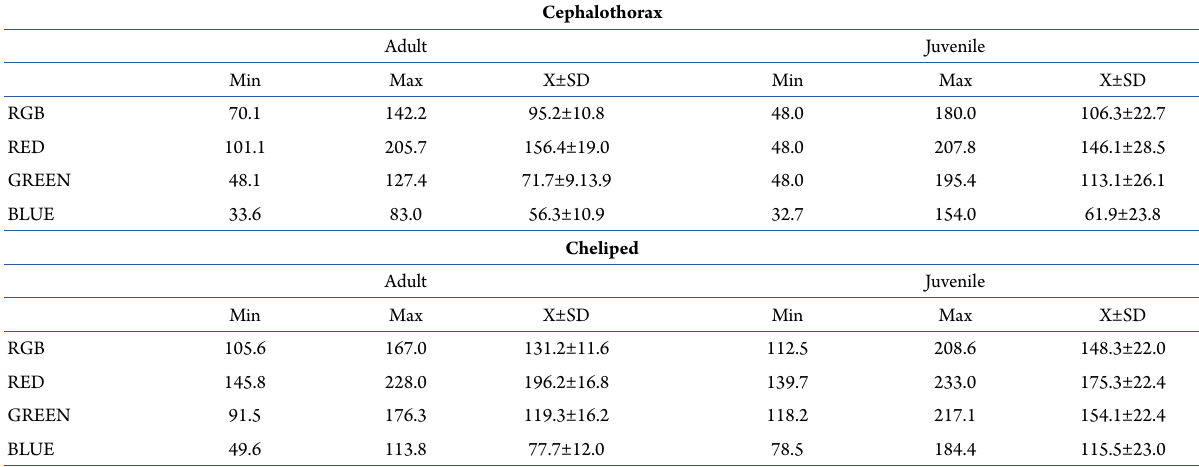
Table 3. Spectrum color values of Dilocarcinus pagei for adults and juvenile by morphological structure. Min. = minimum; Max. = maximum; X = mean; SD = standard